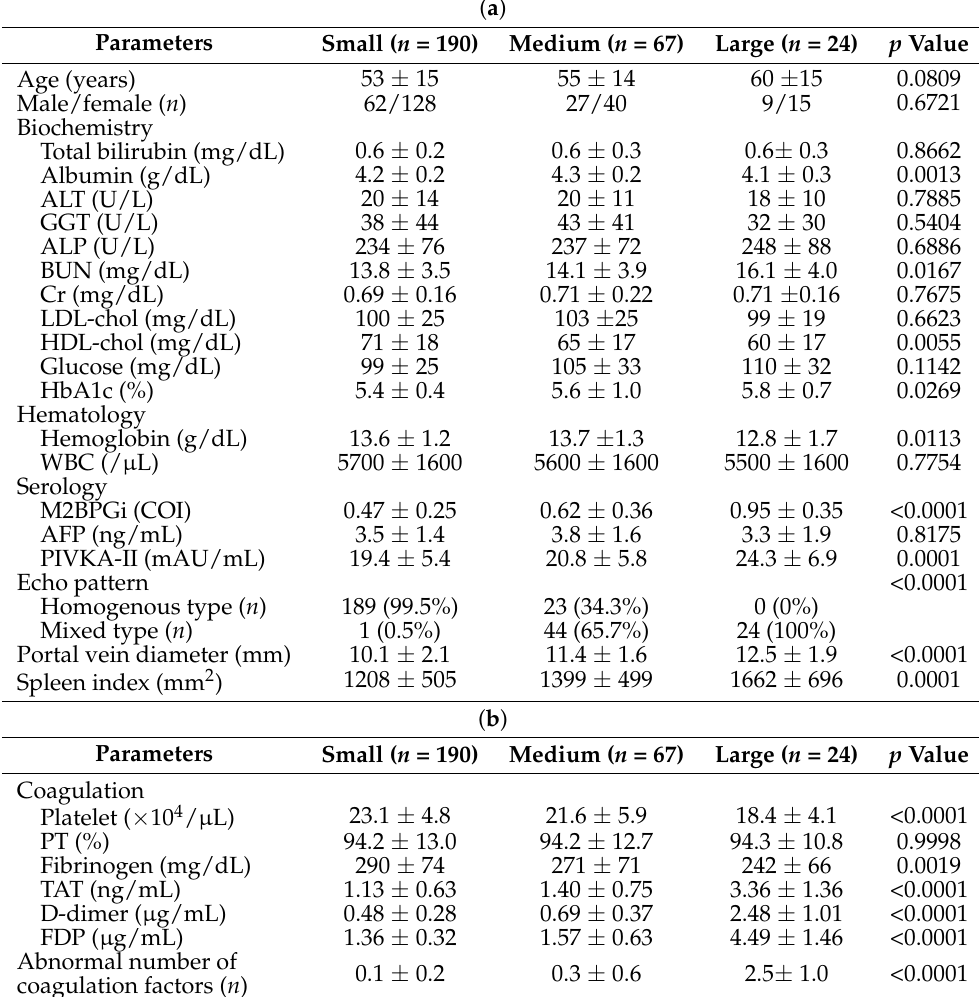
Table 3. ( a ) Relationship between tumor size and clinical parameters in 281 patients with hepatic hemangiomas. ( b ) Relationship between tumor size and coagulation factors in 281 patients with hepatic